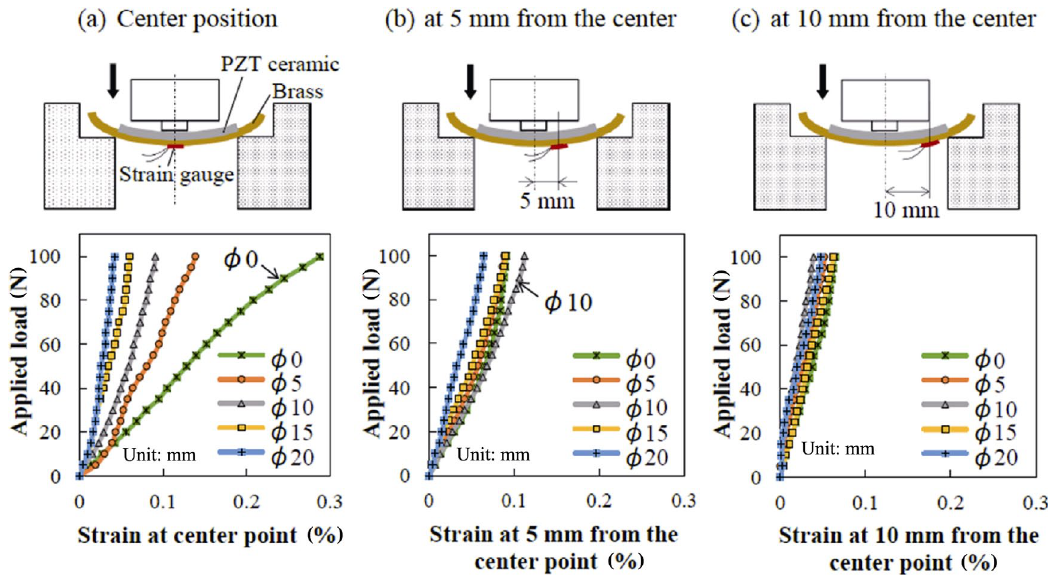
Fig. 8 Applied load as a function of strain at (a) 0, (b) 5, and (c) 10 mm from the center of PZT ceramic.